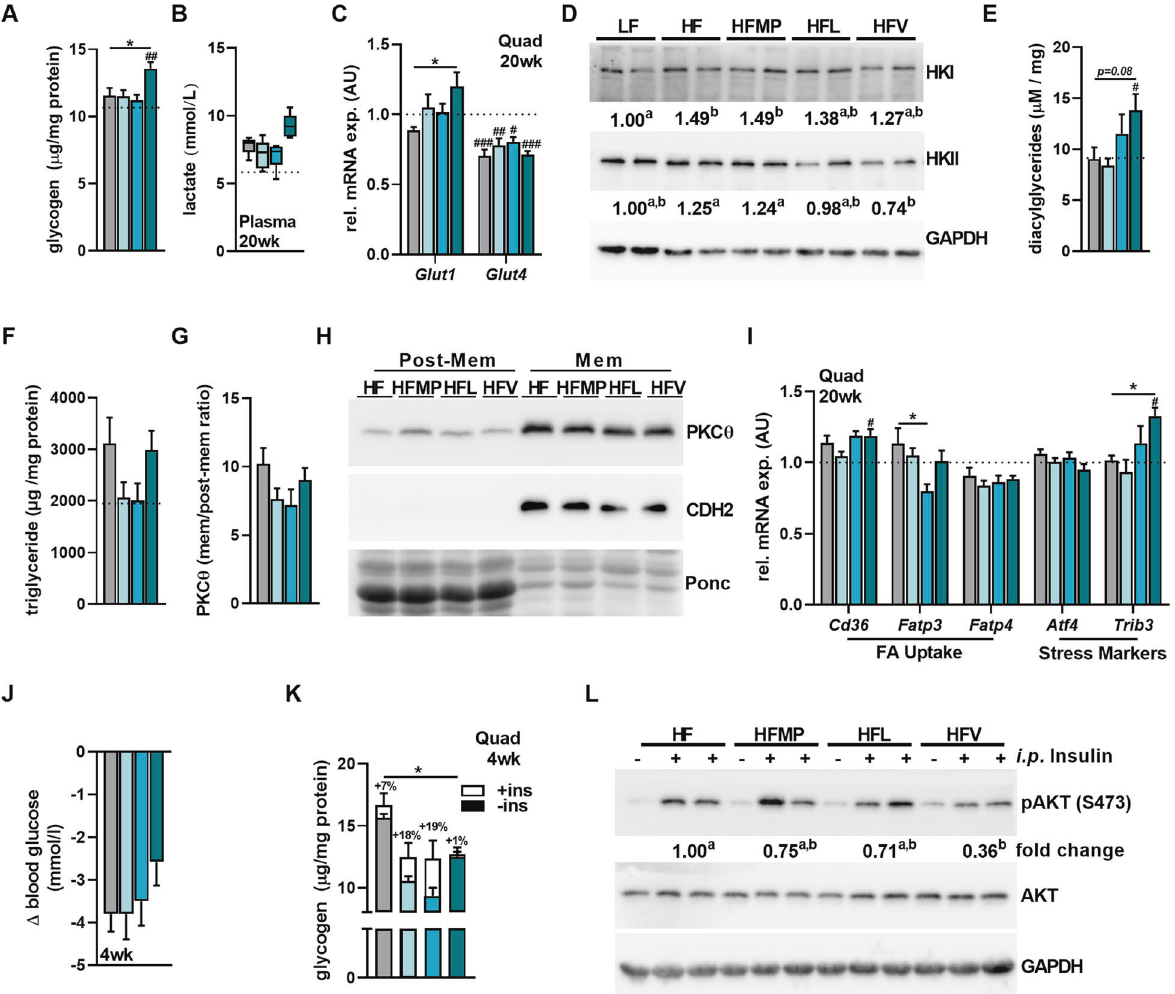
Fig. 4 Valine feeding leads to impaired skeletal muscle insulin signaling. A Quadriceps (quad) glycogen levels in male C57BL/6 JRj mice fed low-fat (LF), high-fat (HF), or experimental HF diets supplemented with milk protein (HFMP), leucine (HFL), or valine (HFV) for 20 weeks ( n = 8). B Two-hour fasting plasma lactate levels at 20 weeks ( n = 6). C qPCR of key genes in glucose transport normalized to LF in quad at 20 weeks with Hprt as reference gene ( n = 8). D Representative western blot of Hexokinase I & II in quad at 20 weeks normalized to LF ( n = 6). E Quad diacylglyceride levels at 20 weeks ( n = 8). F Quad triglyceride levels at 20 weeks ( n = 8). G Ratio of PKC θ localization from membrane (mem) to post membrane (post-mem) fraction ( n = 6). H Representative western blot of PKC θ membrane fractionation normalized to LF. I qPCR of key genes in FA uptake and ER stress normalized to LF with Hprt as reference gene ( n = 8). J Delta blood glucose after 30 min insulin stimulation from 4 week fed mice ( n = 8). K Quad glycogen levels after 30 min insulin stimulation from 4 week fed mice ( n = 8). L Representative western blot of insulin stimulated (30 min) AKT phosphorylation in quad of mice fed for 4 weeks ( n = 8). Fold change in Western blots ( L ) refers to insulin induced change normalized to HF. Plasma data ( B ) are expressed as interleaved box and whiskers (min to max) plots. All other data are shown as mean + SEM except for western blot quanti fi cation where only mean of signal or fold change is indicated below representative blots. LF is represented as dotted line. * p < 0.05; ** p < 0.01; *** p < 0.001 compared to HF and # p < 0.05; ## p < 0.01; ### p < 0.001 compared to LF. Different letters represent signi fi cant difference between groups in Western blots. FA, fatty